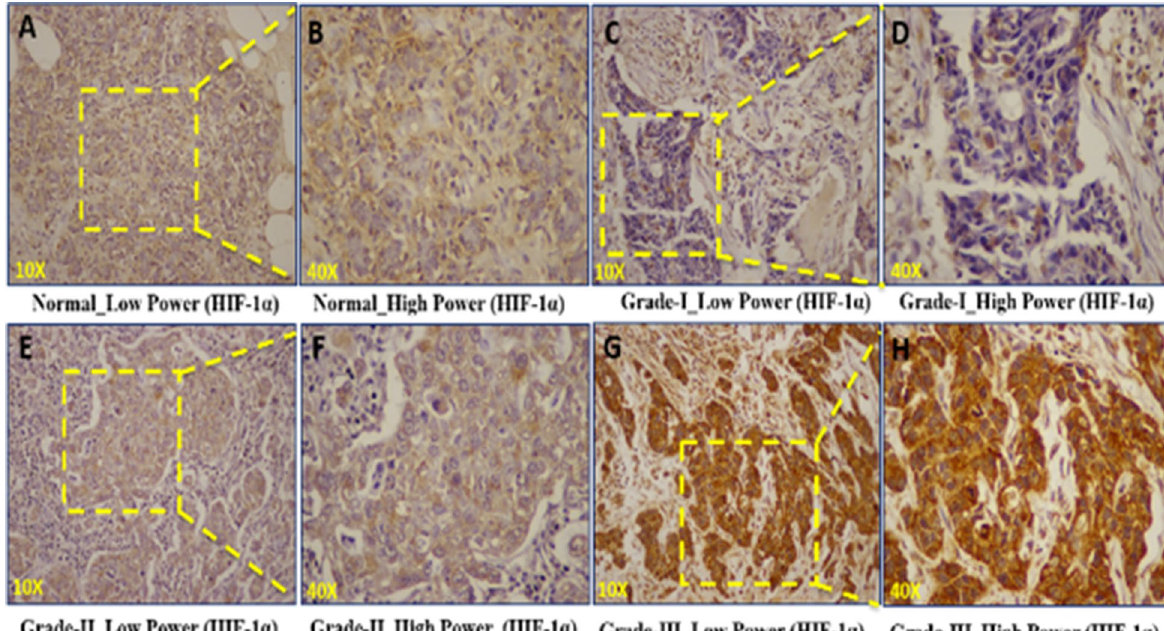
Fig. 2 Immunohistochemical expression of hypoxia-inducible factor-1 alpha (HIF-1α) with increasing grade in Breast Carcinoma. The expression of HIF-1α was mostly nuclear, but in some cells, cytoplasmic positivity was also observed. A Normal tissue (10X), B Normal tissue (40X), C Grade I(10X),